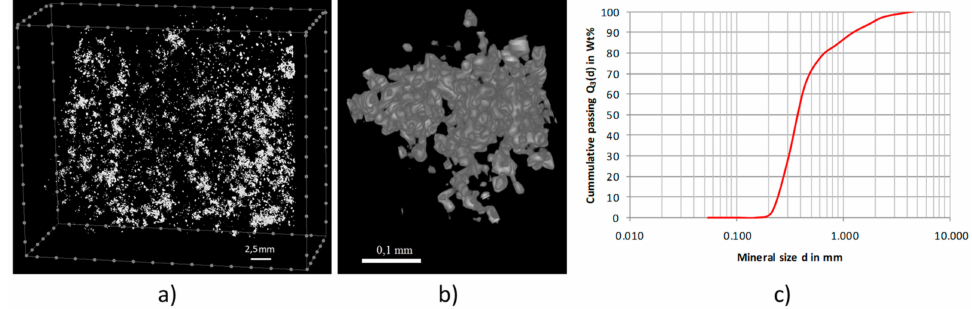
Figure 7. ( a,b ) Aggregates of copper minerals in the volume of sandstone and ( c ) aggregate distribution according to the maximum